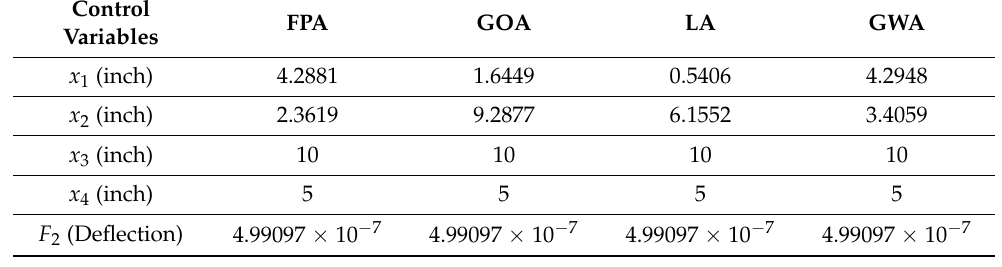
Table 10. Optimal results of the GWA, FPA, LA, and GOA for TLSM design under first case.